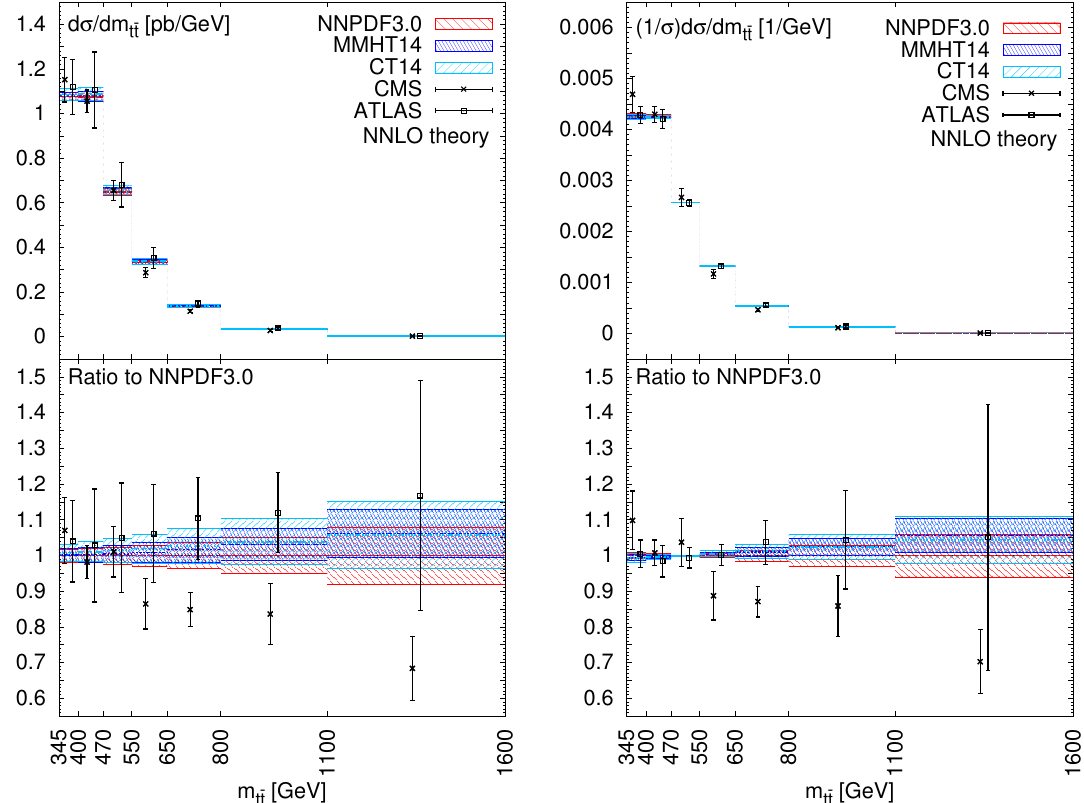
Figure 11 . Same as (cid:12)gure 5 for the invariant mass distribution of the top-antitop pair, m t (cid:22) t .